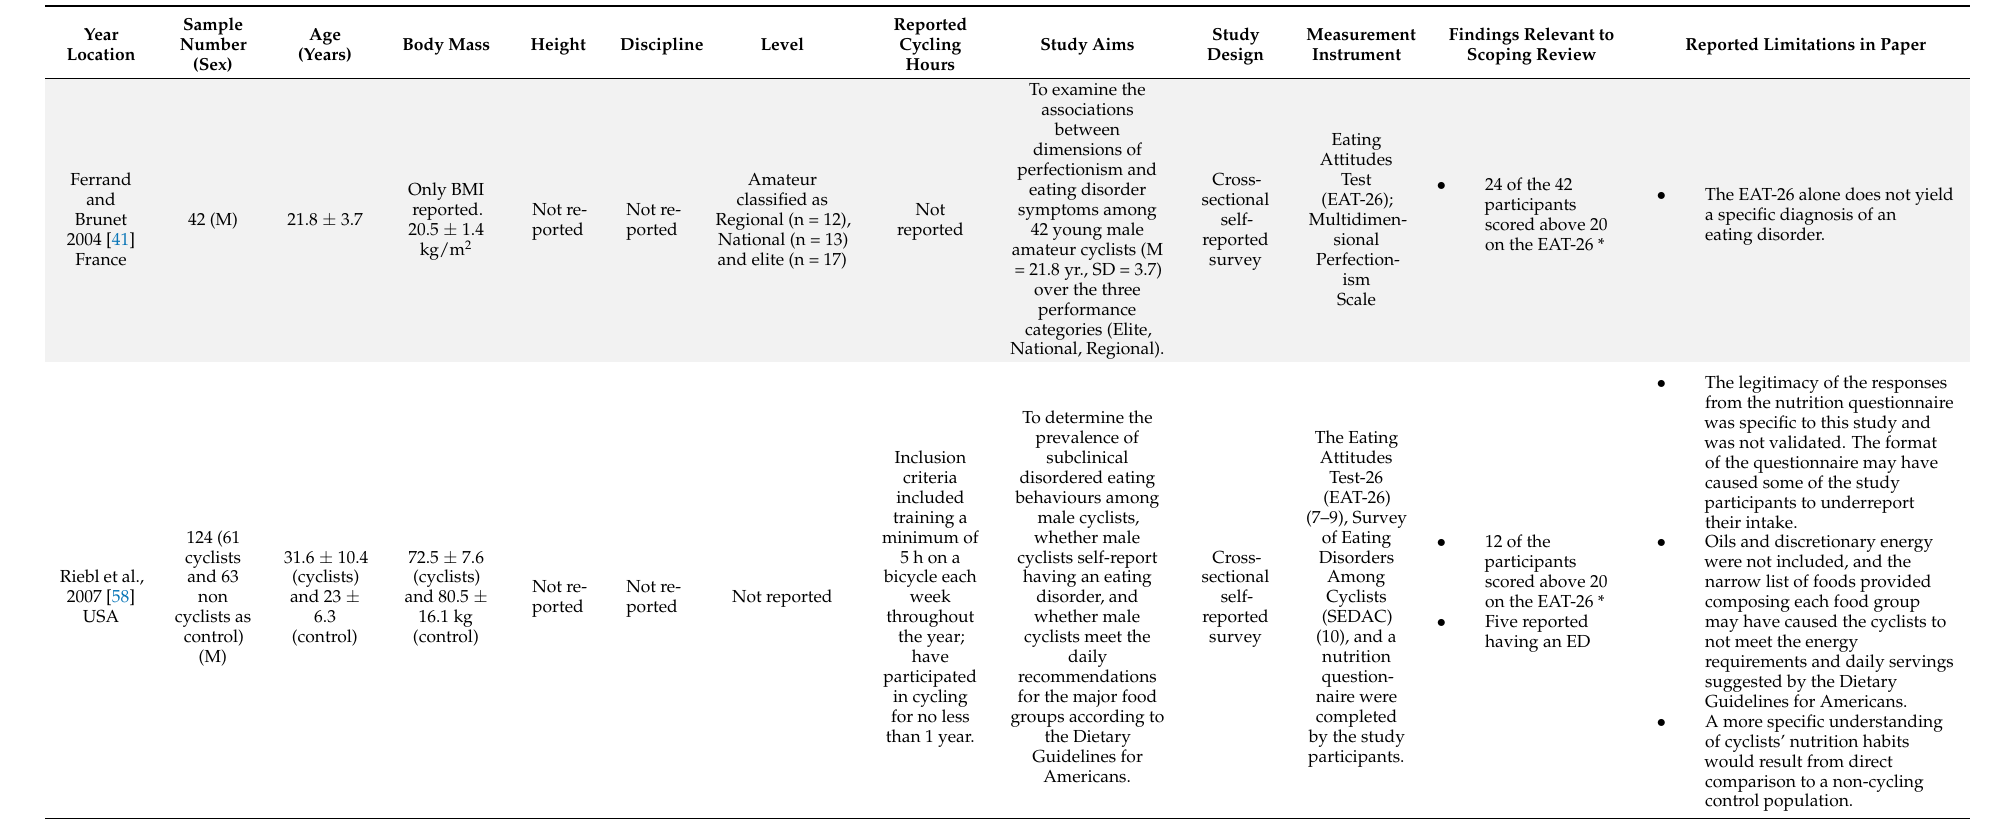
Table 1. Overview of data extracted from reviewed